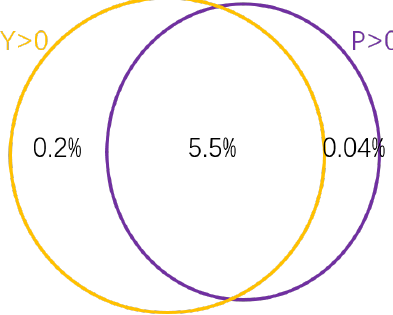
Figure 6 . Comparison of the D stu bounds and the